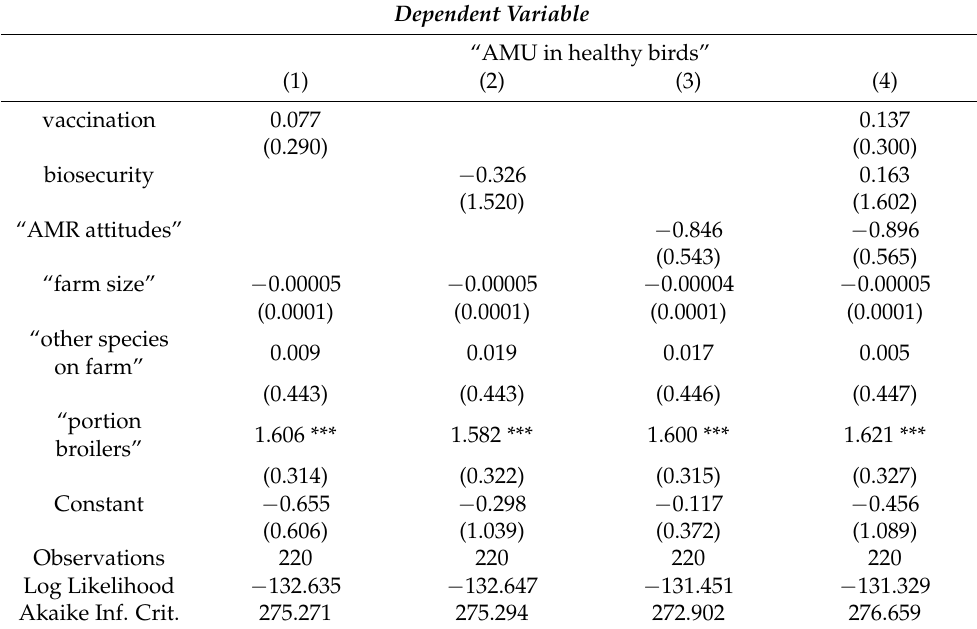
Table 3. Determinants of antibiotic use in healthy birds.